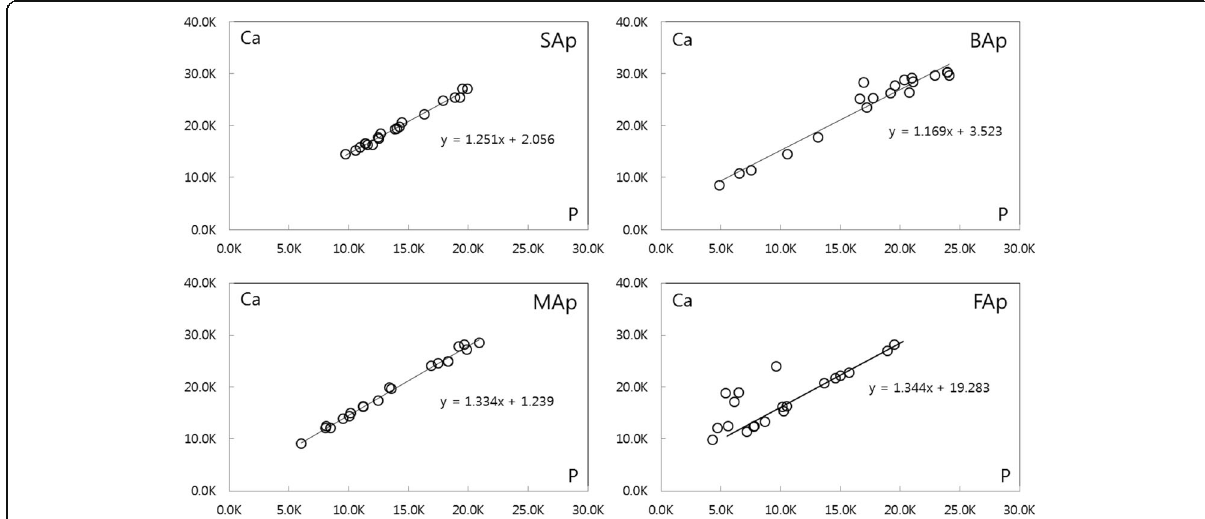
Fig. 3 Correlation of the Ca and P intensities for apatite phases obtained at 15 kV using the Mini-SEM. The data of the reference materials, SAp and MAp, show constant and straight lines. The slope of the trend line from BAp indicates lower Ca/P compared to SAp and MAp. FAp shows certain data points distributed outside the line, which suggests the presence of Ca-rich minerals other than apatite, such as calcite (CaCO 3 )